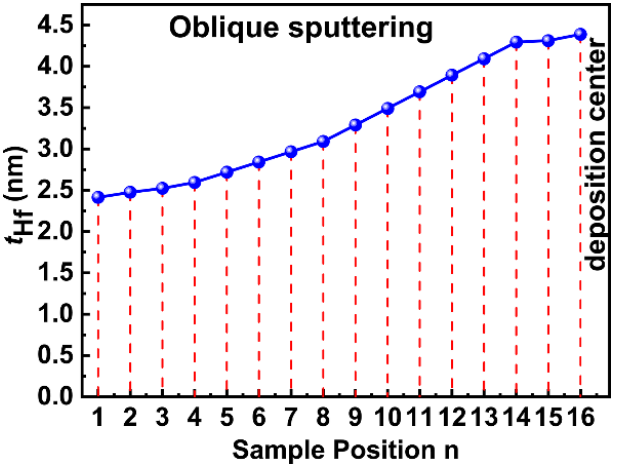
Figure 2. Sample position n dependence of the calculated Hafnium thickness t Hf .